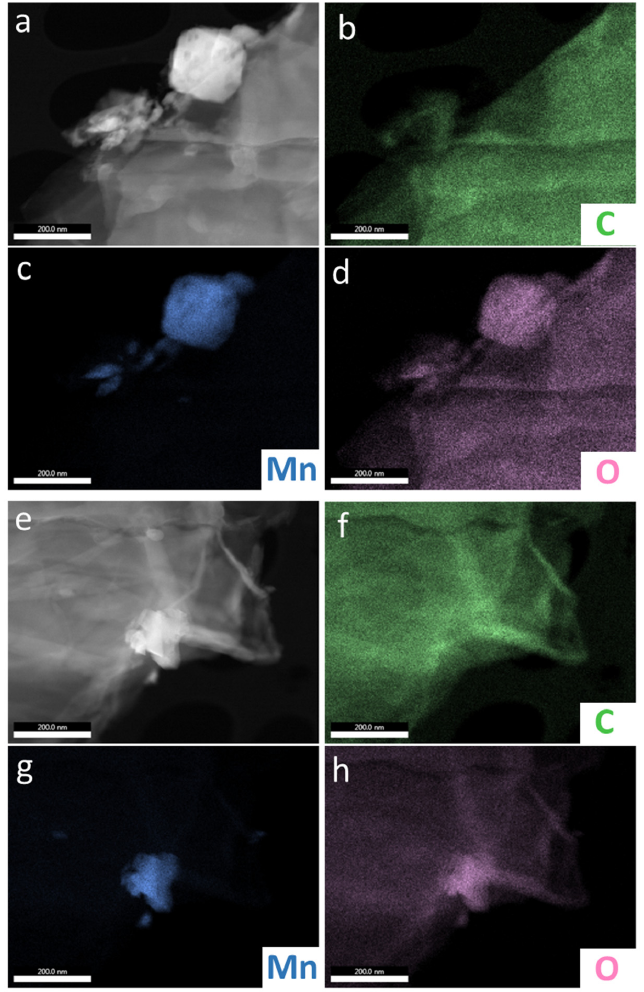
Figure 5. EDS analysis of LMO with 5%wt. GO composite: STEM images ( a , e ) and corresponding carbon ( b , f ), manganese ( c , g ), and oxygen ( d , h ) maps measured at two different regions of the sam- ple.